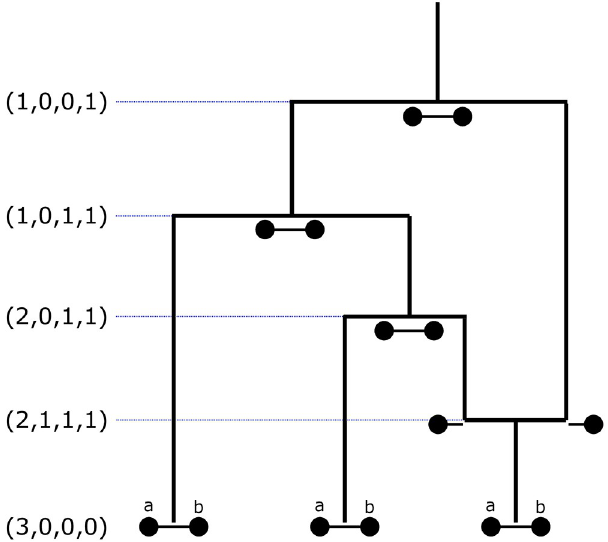
Fig 3. Example trajectory of A r ð t Þ with the state denoted by tuples. At t = 0 there are three lineages of type k ancestral to both loci for their respective samples. The lineages split at ancestral recombination events and join at coalescence events where they find a common ancestor. The trajectory ultimately culminates in the state (1, 0, 0, 1), signifying that there is one lineage ancestral to both loci in all present-day samples, and that one recombination event occurred in this genealogy.